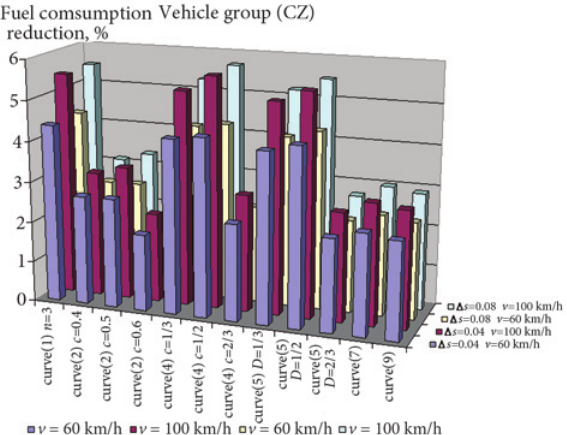
Fig. 11. Fuel consumption reduction in variant B, % in vehicle group (CZ)